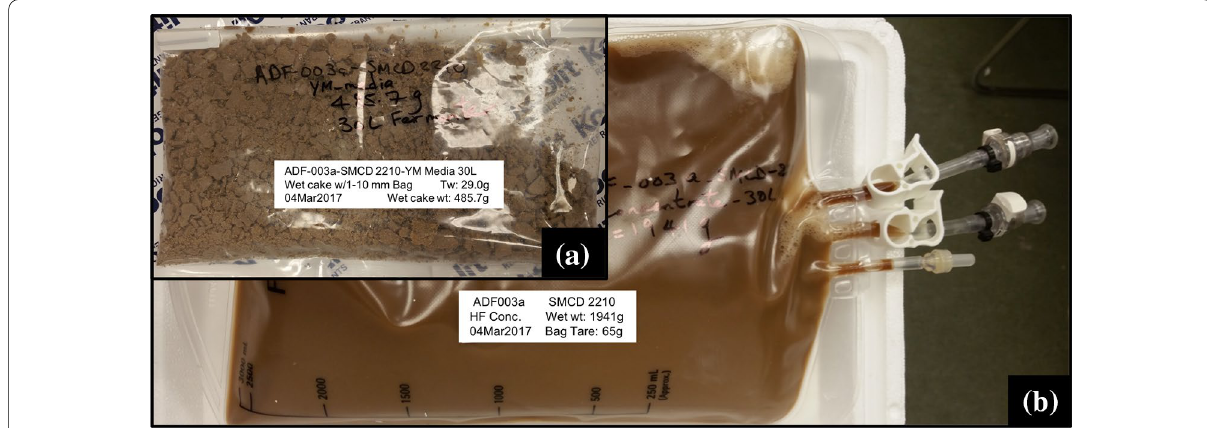
Fig. 6 Scale-up Paraconiothyrium sp. SMCD fermentation product as a wet cake obtained from basket centrifugation and b liquid biomass consisting of spores concentrated from the centrate by hollow fibre